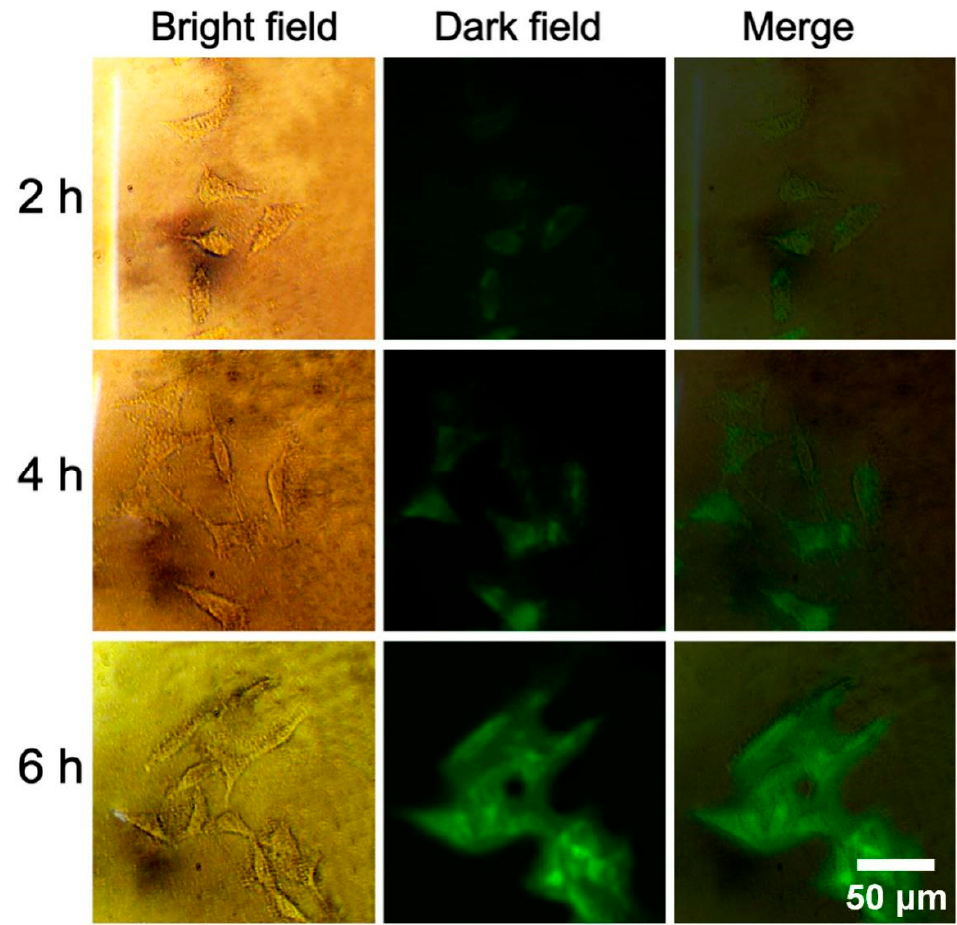
Figure 7. Fluorescent photograph of MCF-7 treated with HNTs-FITC-ICG-RBCM-SA-EpCAM at different time intervals.